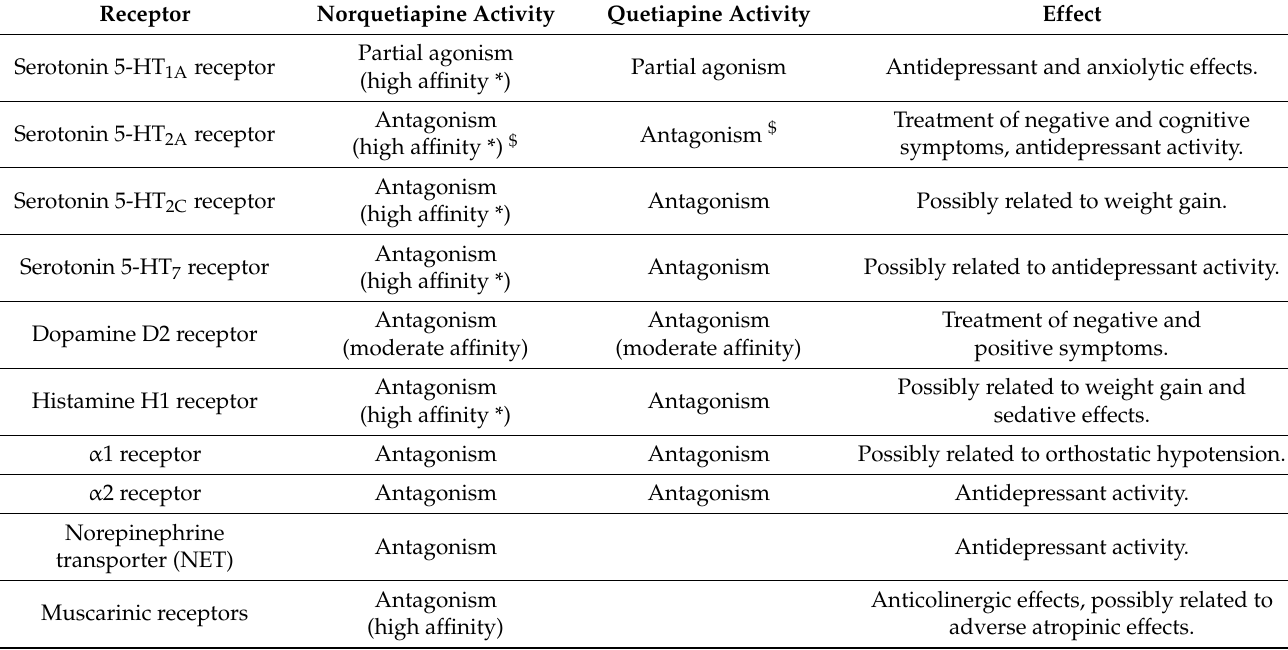
Table 1. Proposed pharmacodynamics explaining the mechanism of action of quetiapine and